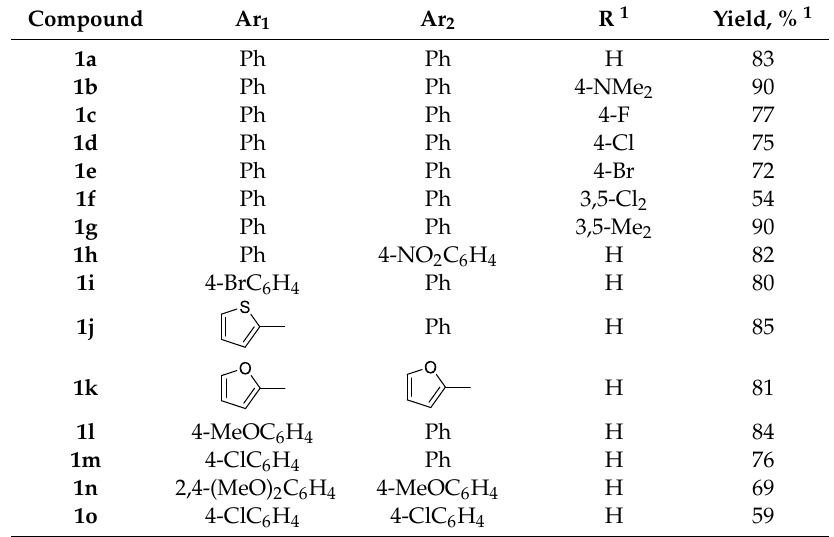
Table 1. Results of the multicomponent reaction leading to dihydroterphenyl derivatives 1 .